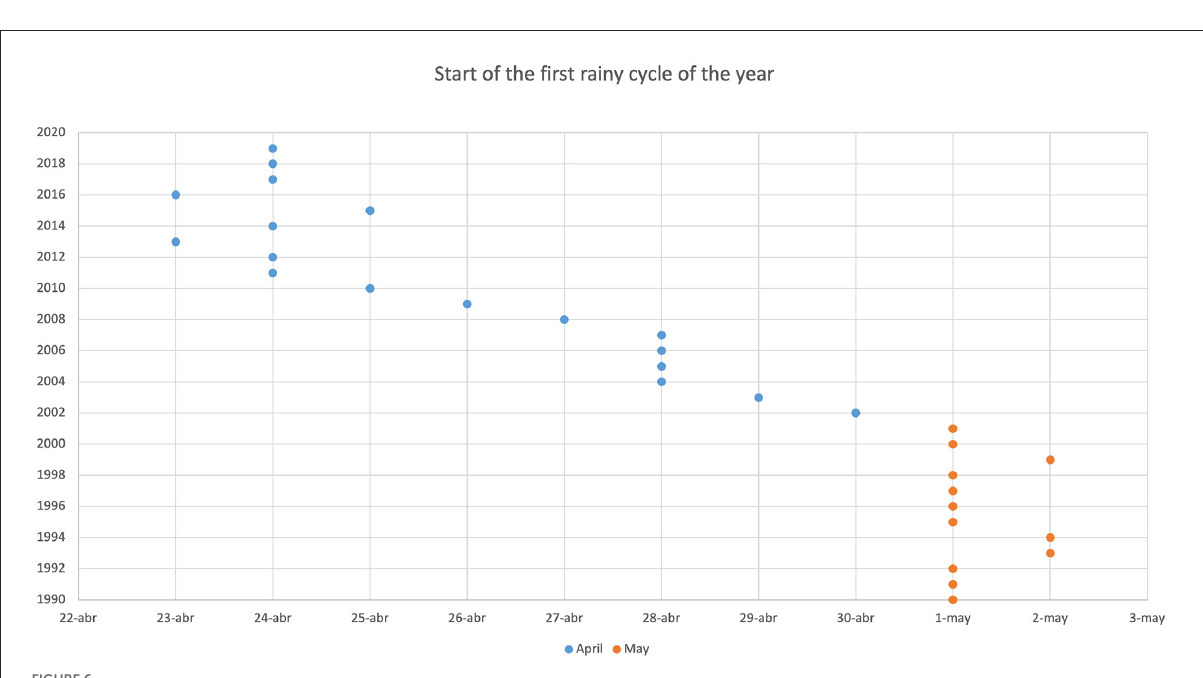
FIGURE6 Changes in the start day of the May rain cycle since 1990 in the study area. The orange dots indicate the start day of the first rain cycle of the year from 1990 to 2000, the blue dots show the beginning of the rainy season from 2002 to 2020. Precipitation onset has anticipated for 8 days since